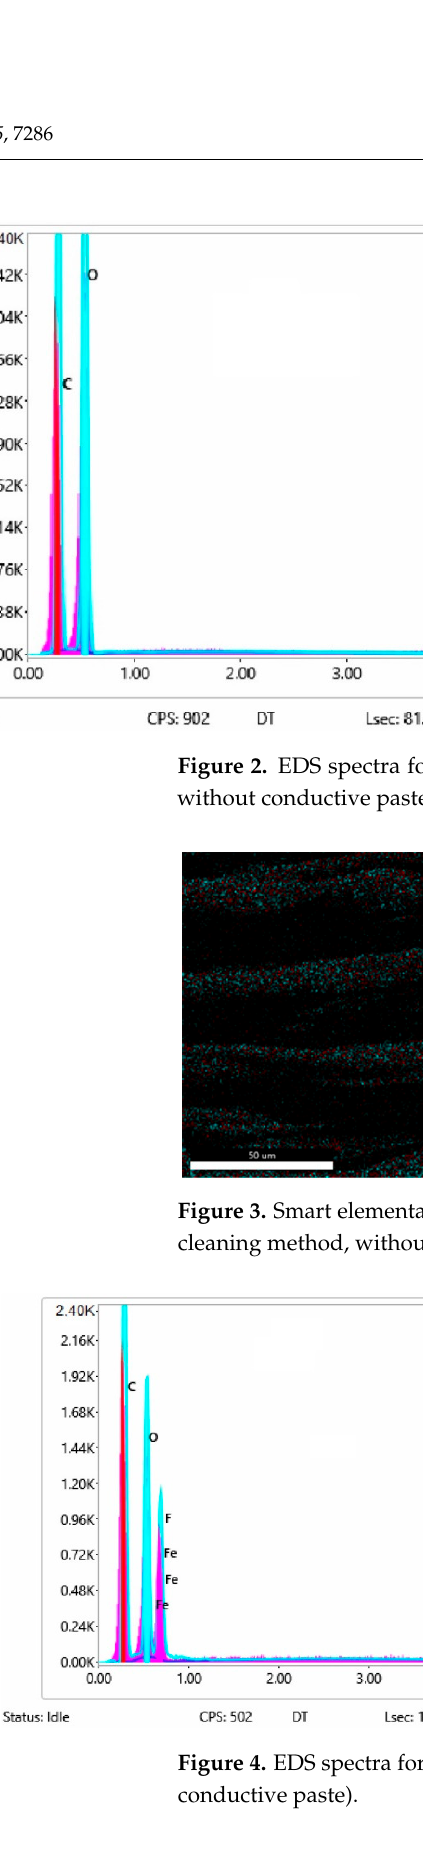
Figure 5. Smart elemental mapping overlay for sample 2: ( a ) untreated with artificial perspiration; ( b ) treated with acid perspiration; ( c ) treated with alkaline artificial perspiration.